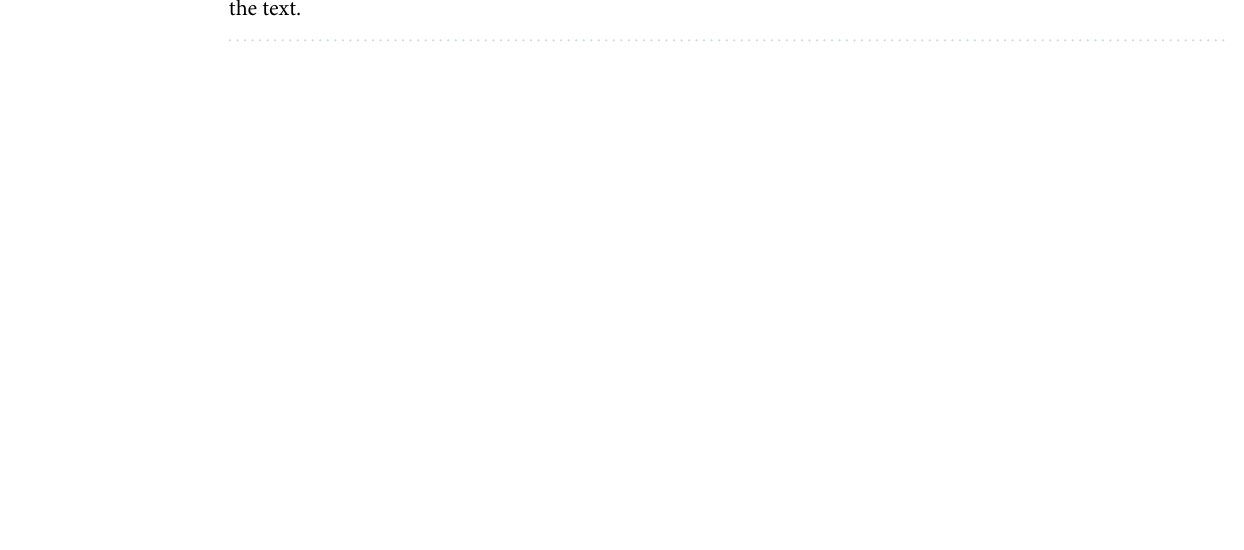
Table 8. Comparative biological analysis of LGG dataset. The bold values indicate the best score as reported in the